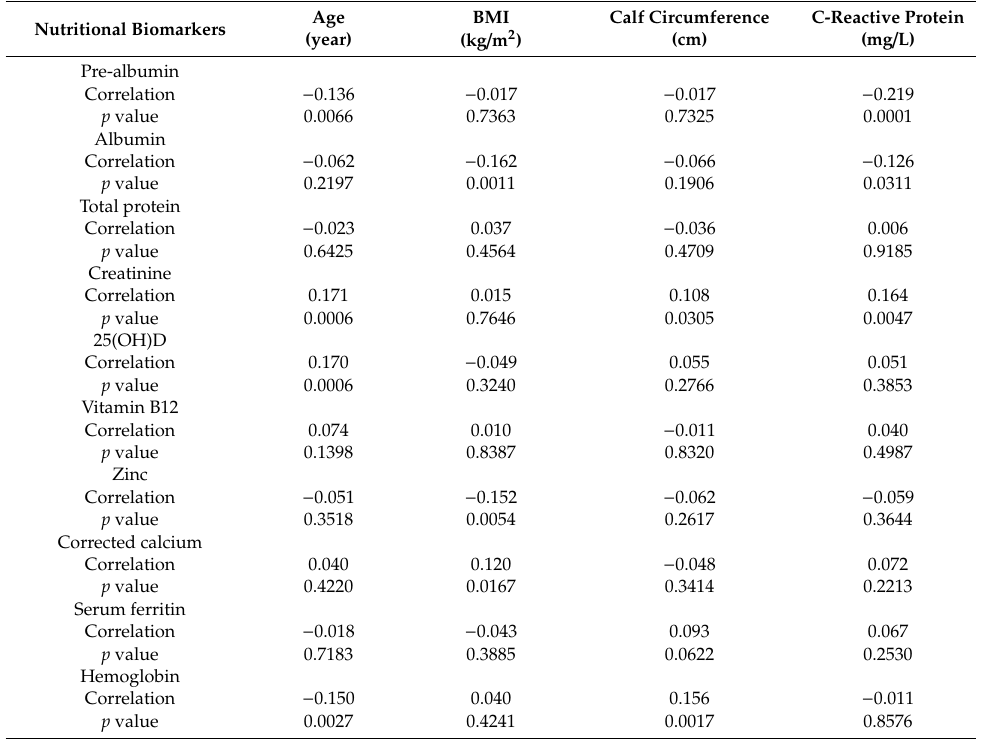
Table 3. Correlations of various factors with nutritional biomarkers